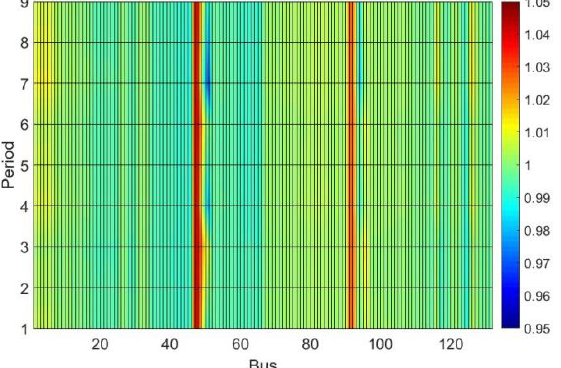
Figure 10. IEEE 123-bus system, voltage magnitudes of phase A, continuous taps, 20% PV.